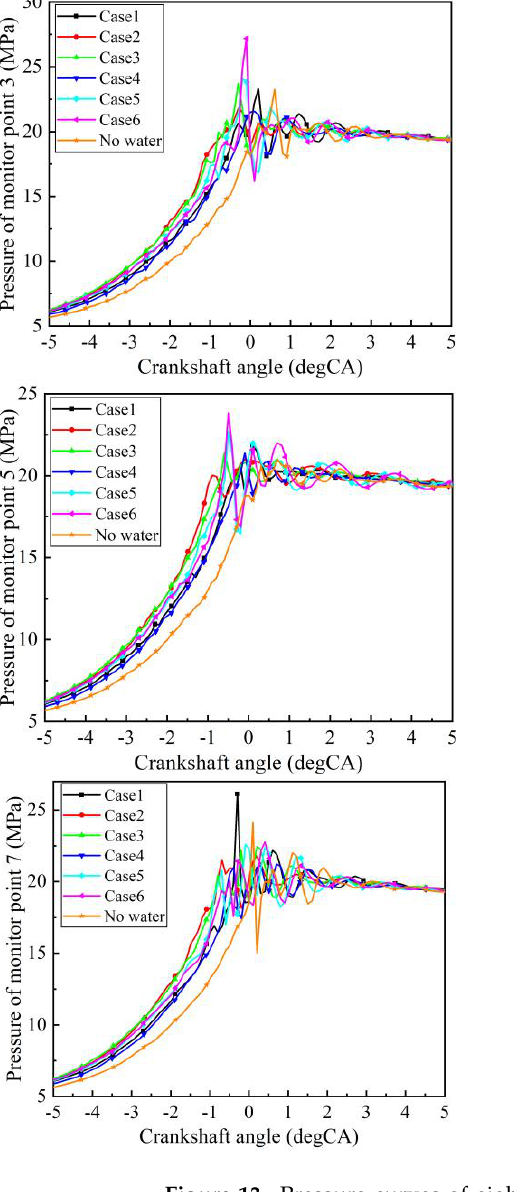
Figure 14. OH radical mass in the cylinder in different water injection cases (CR = 10.3, ignition time = − 14 degCA).